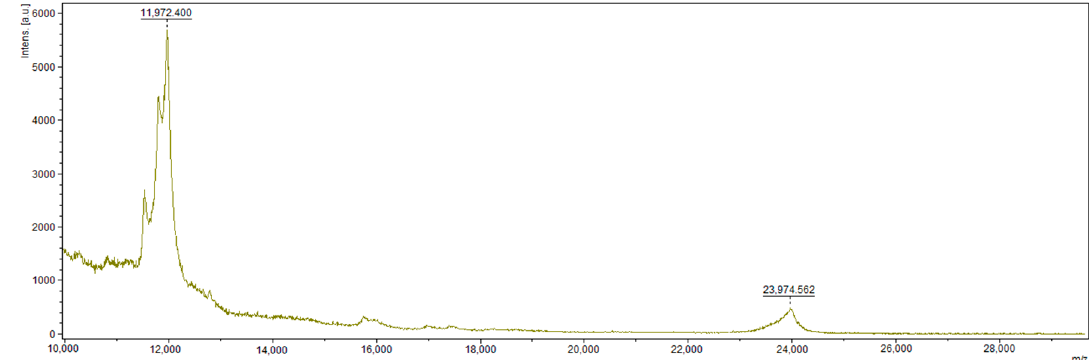
Figure 3. Spectrum obtained for casein in the 10–30 kDa molecular mass range using HCCA+DHB matrix (HCCA in acetone).